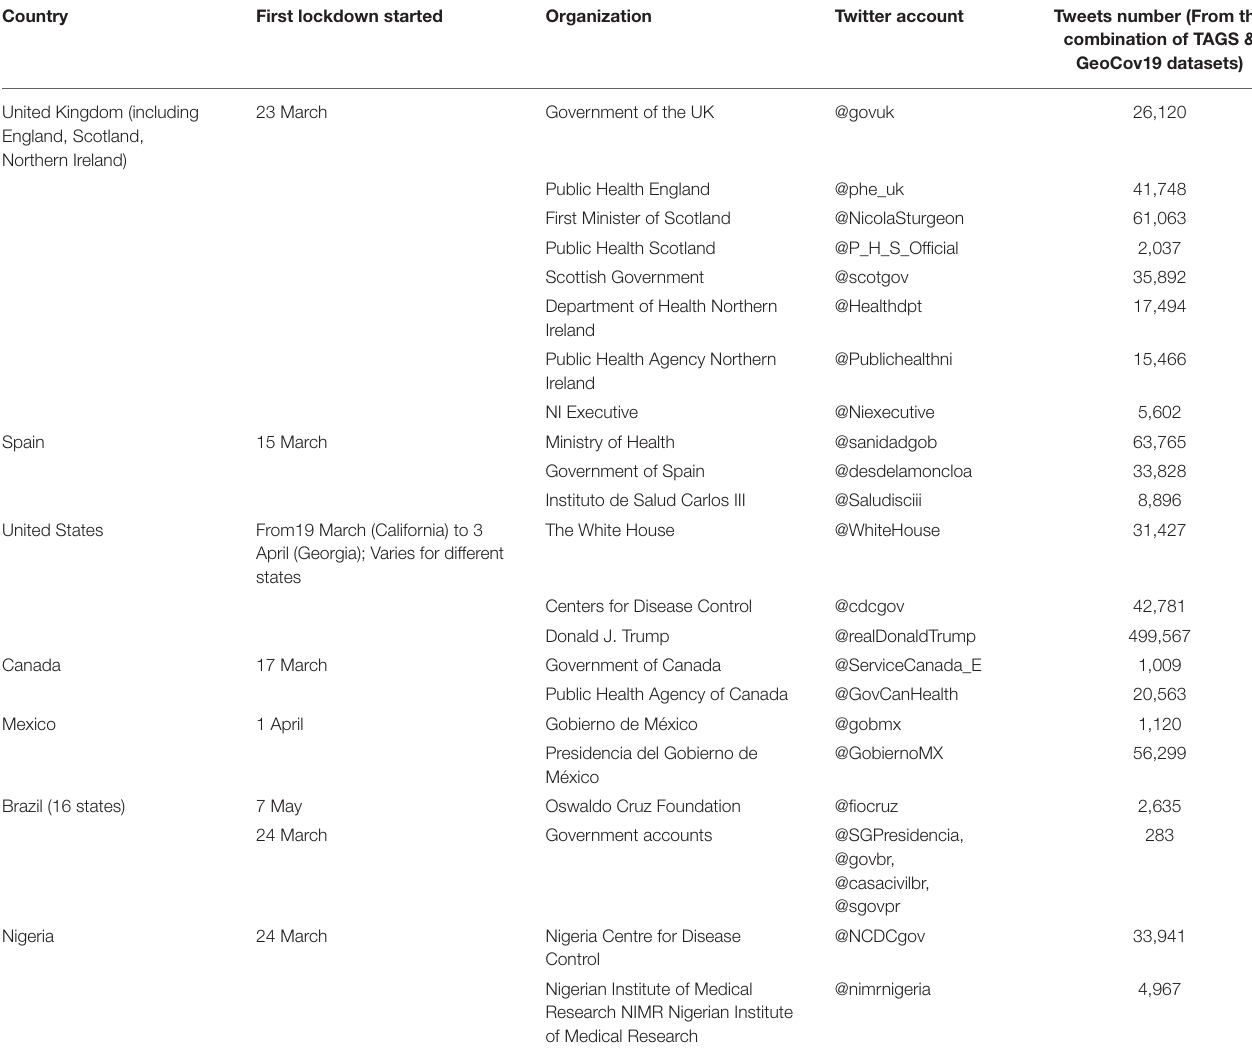
TABLE 1 | Selected accounts and the total number of tweets in the final combined dataset.